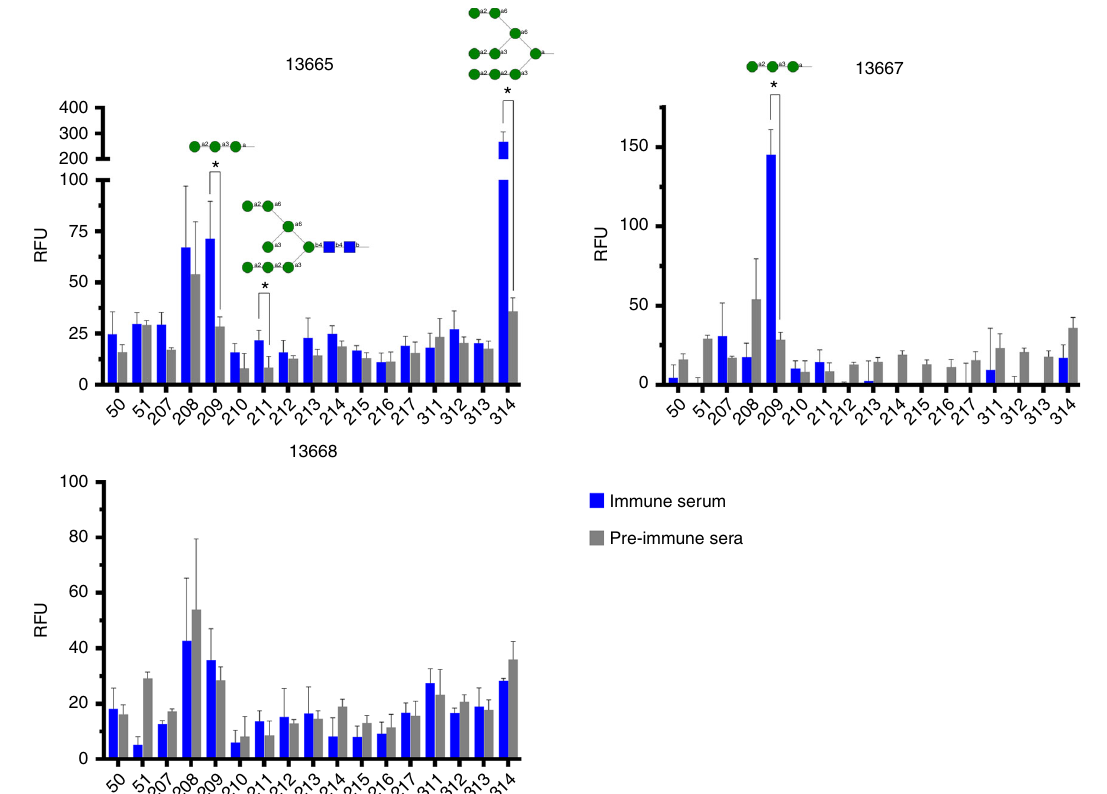
Fig. 7 Immune sera contain elevated levels of oligomannose-speci fi c antibodies with select speci fi city as revealed by glycan array analyses. Immune sera ( n = 3) and a pre-immune control comprised of pooled pre-immune sera from the same three animals were assayed on printed glycan arrays (NCFG; version 5.3) consisting of various synthetic and naturally derived glycosides. Shown is serum IgM antibody detection at a dilution of 1:10 as measured by fl uorescence ( y axis). The assayed glycans are referenced by their identi fi cation numbers on the printed array ( x axis). For clarity, only results (from sextuplicate replicates, with outlier signals removed) for high-mannose glycosides and partial structures thereof are shown here. Symbolic representations of the glycosides to which the immune sera bound signi fi cantly more strongly than pre-immune control are shown. Statistical signi fi cance was determined using the Holm – Sidak method (* P < 0.05). Each glycoside was analyzed individually (immune serum vs. pre-immune control), without assuming a consistent standard deviation. The chemical sequences of all arrayed glycosides are listed in Supplementary Table